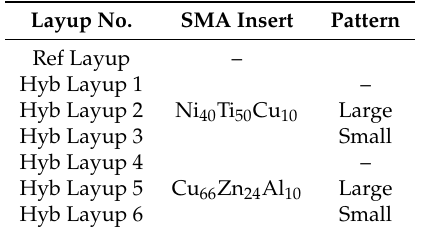
Table 5. Layups of the cantilever beams investigated.